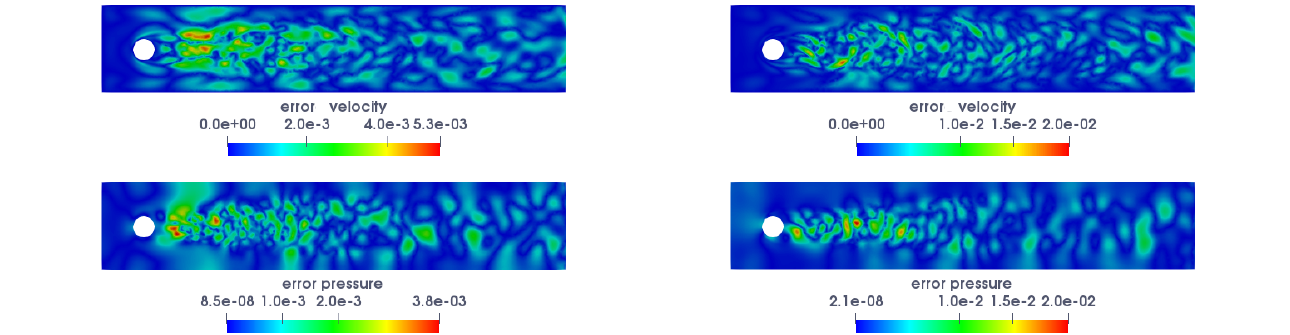
Figure 5. Test case 1: Relative errors (cid:101) k for the testing-parameter instance µ test = 1.975 m/s, with N = 256 and n = 5. Relative errors at t = 1.062 s ( left ) and t = 4.842 s ( right ) for velocity ( top ) and pressure ( bottom ).